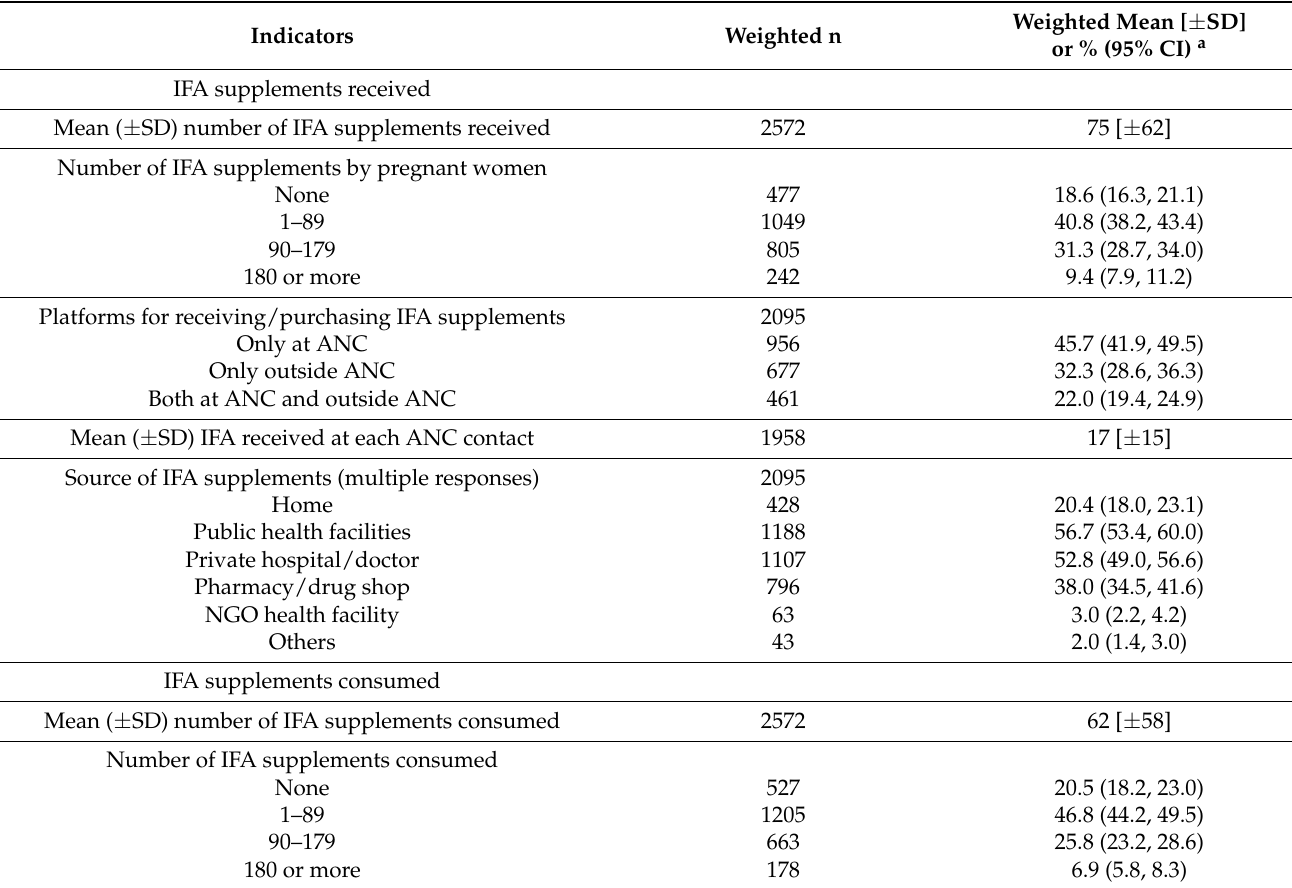
Table 2. Women receiving IFA supplements during pregnancy by number of supplements, service delivery platform and source, and consumed IFA